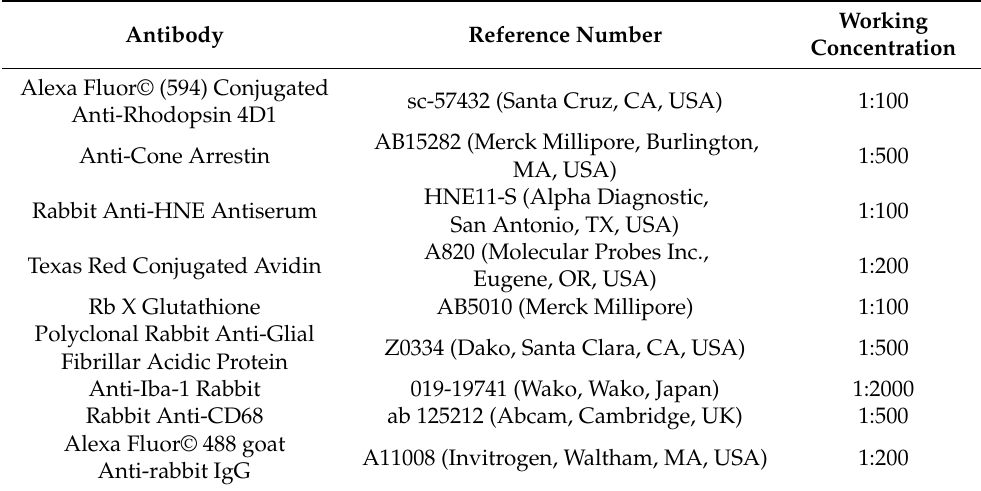
Table 1. Primary and secondary antibodies employed in immunohistochemistry and working concentration. Working Antibody Reference Number Concentration Alexa Fluor© (594) Conjugated sc-57432 (Santa Cruz, CA, USA) 1:100 Anti-Rhodopsin 4D1 AB15282 (Merck Millipore, Burlington, 1:500 Anti-Cone Arrestin MA, USA) HNE11-S (Alpha Diagnostic, 1:100 Rabbit Anti-HNE Antiserum San Antonio, TX, USA) A820 (Molecular Probes Inc., 1:200 Texas Red Conjugated Avidin Eugene, OR, USA) Rb X Glutathione AB5010 (Merck Millipore) 1:100 Polyclonal Rabbit Anti-Glial 1:500 Fibrillar Acidic Protein Anti-Iba-1 Rabbit 019-19741 (Wako, Wako, Japan) 1:2000 Rabbit Anti-CD68 ab 125212 (Abcam, Cambridge, UK) 1:500 Alexa Fluor© 488 goat Anti-rabbit IgG